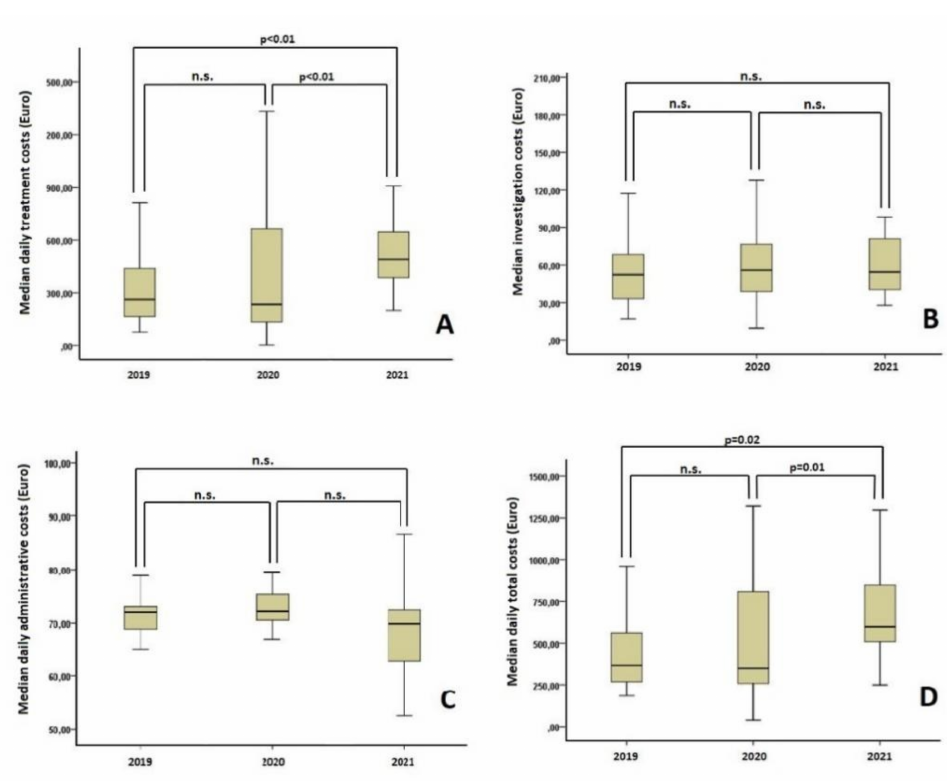
Figure 1. Comparison of costs among the three time cohorts. ( A ). Comparison of treatment costs; ( B ) comparison of investigation costs; ( C ) comparison of administrative costs; ( D ) comparison of total costs. n.s.—non-statistically significant.